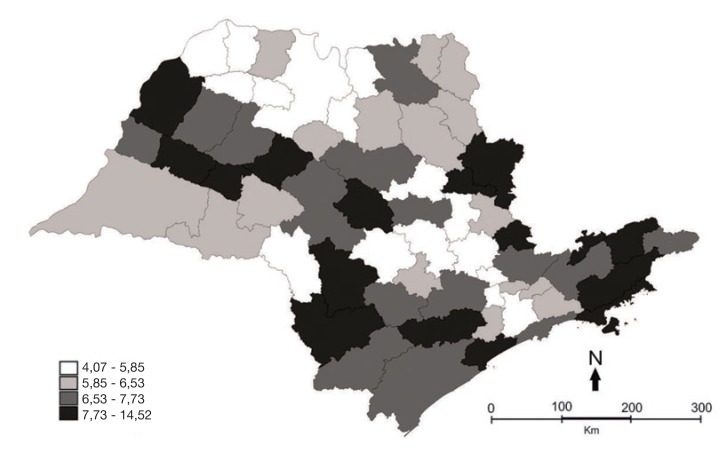
Mapa temático da distribuição das taxas de mortalidade neonatal precoce,
por 1000 nascidos vivos, segundo microrregiões, São Paulo, 2006-
2010